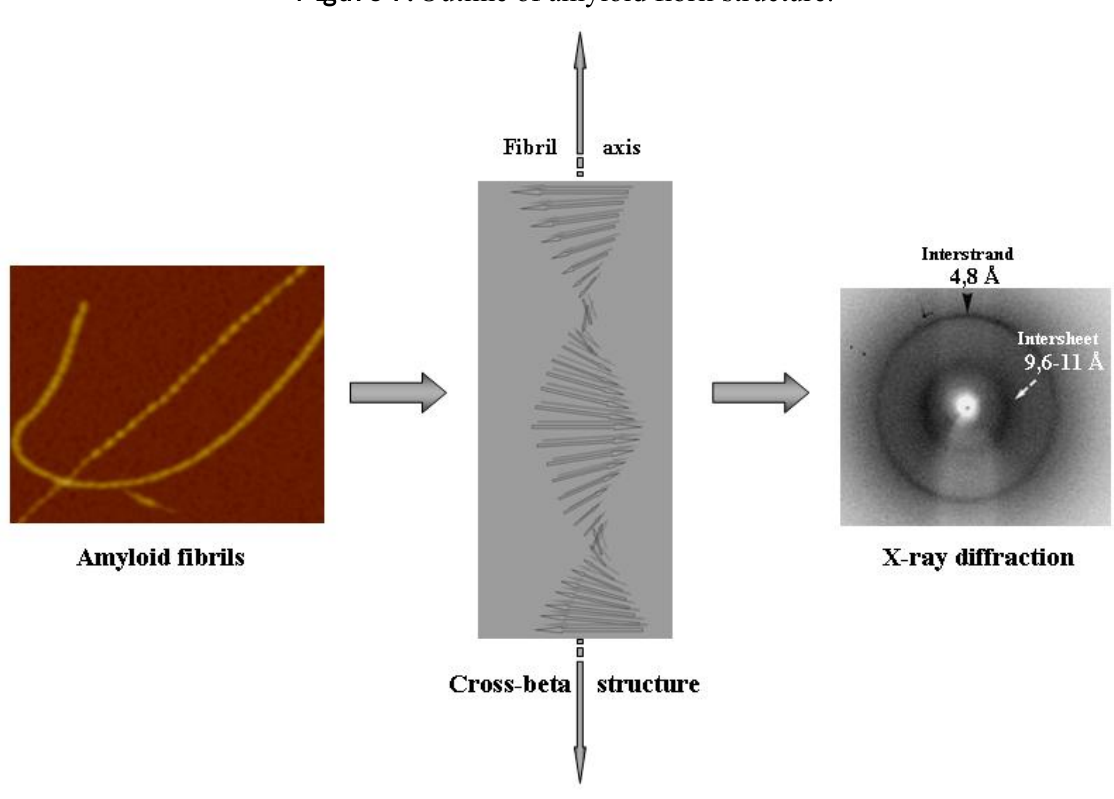
Figure 1. Outline of amyloid fibril